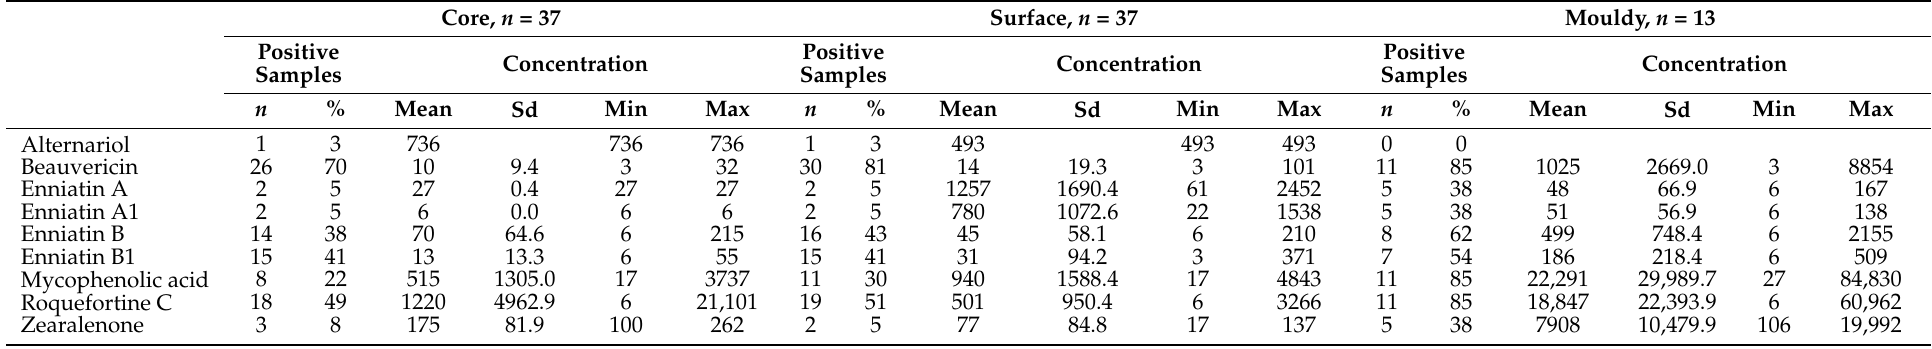
Table 3. Incidence and concentrations of mycotoxins ( µ g/kg dry matter) in grass silage. Values represent only samples where the specific mycotoxin was detected.